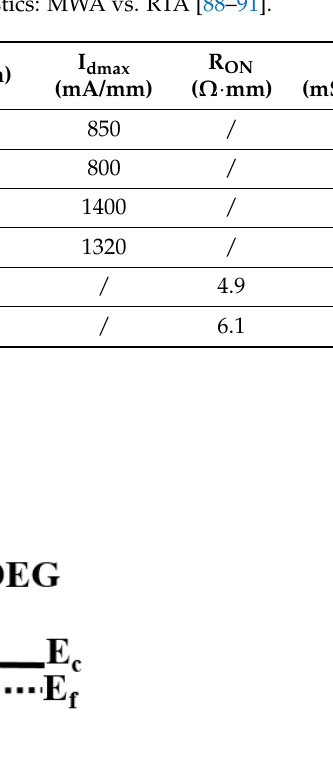
Table 5. GaN-based HEMTs devices’ electrical characteristics: MWA vs. RTA [88–91].